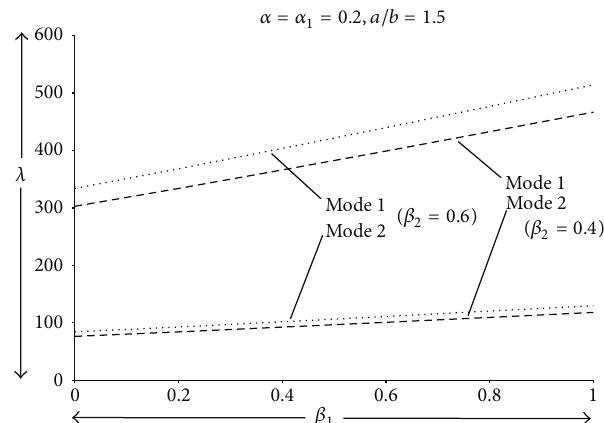
Figure 4: Frequency versus taper constant ( 𝛽 1